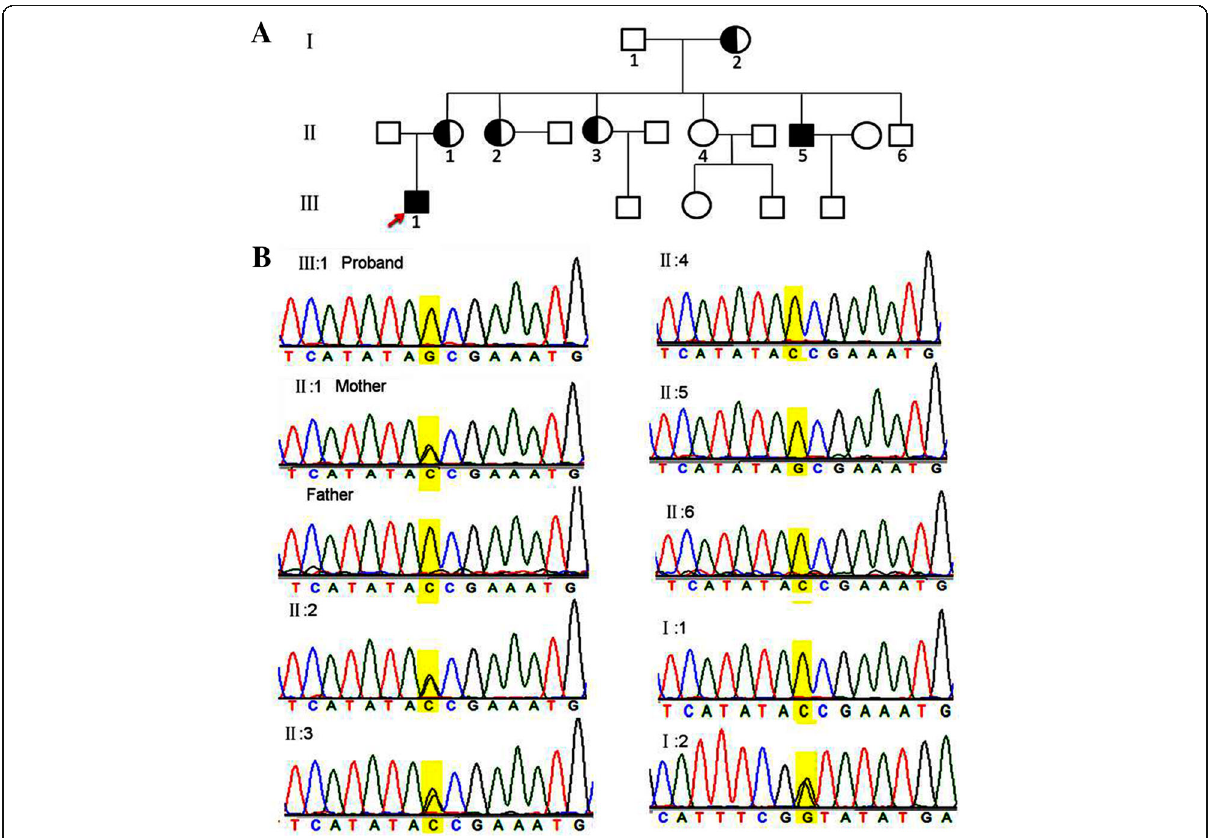
Fig. 2 The pedigree and Sanger identification of the novel mutation. a The black-solid square represents the affected male patient. The black- shadow circle represents the female carrier. Unfilled squares and circles indicate normal males and females respectively. b The Sanger sequencing traces illustrated the NHS c.C4449G, p.Tyr1483Ter mutation in individualsI:2, II:2 and II:3 (hemizygous), and individuals II:5 and III:1